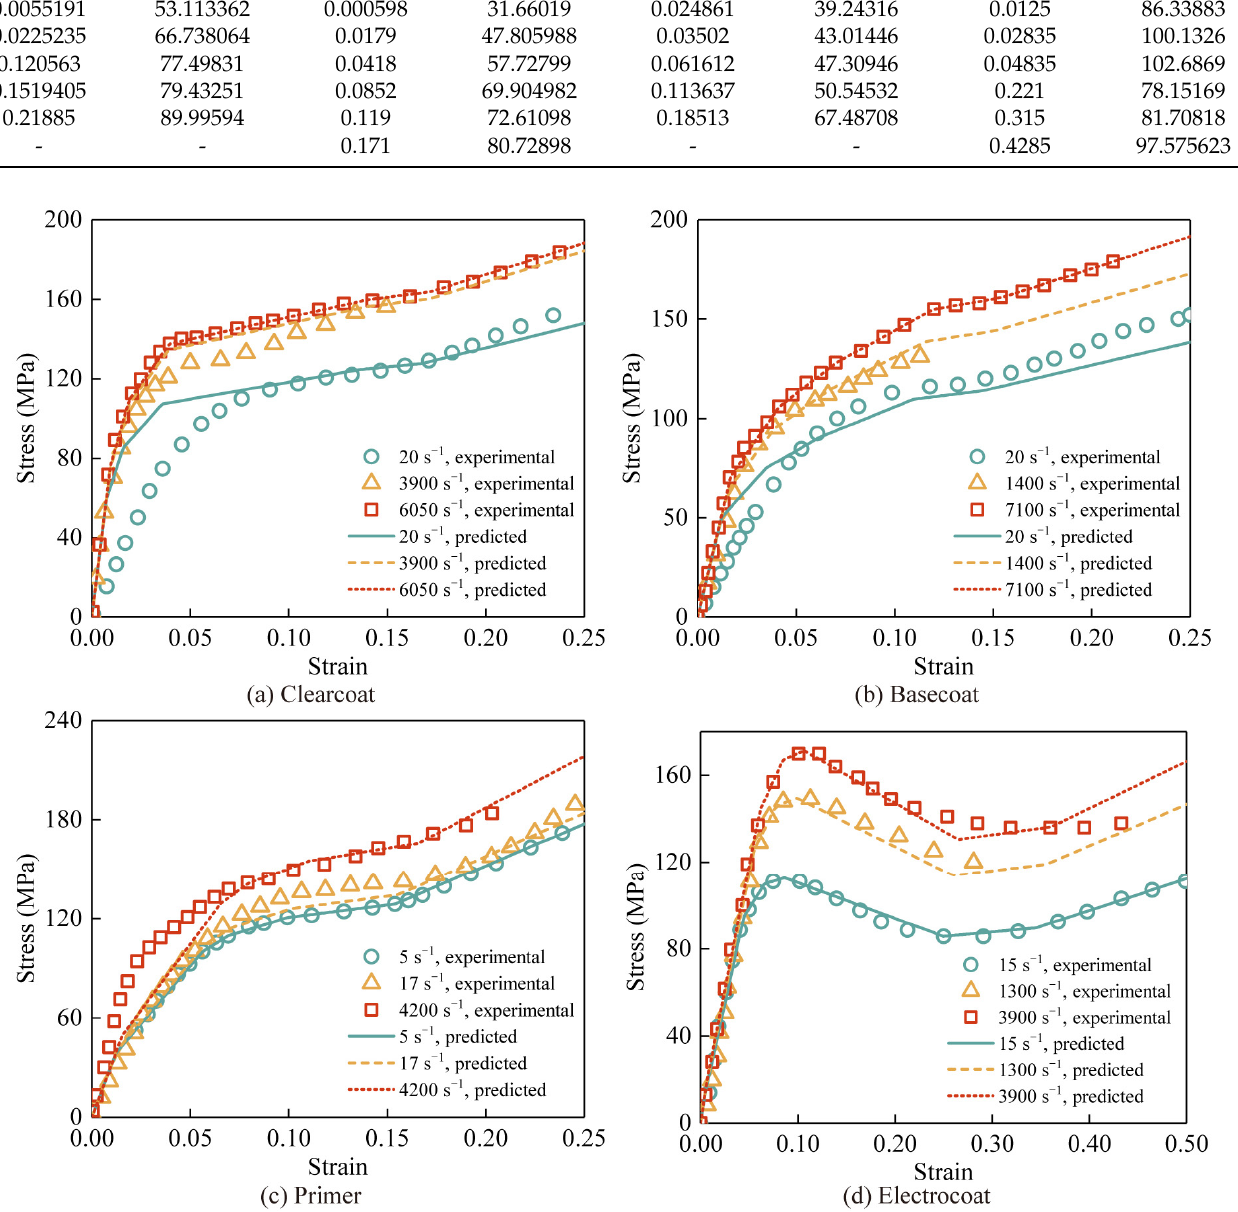
Figure 3. Comparison between experiment data [57,58] and predicted stress–strain curves of four paint films, i.e., ( a ) clearcoat, ( b ) basecoat, ( c ) primer, and ( d ) electrocoat, at different strain rates.